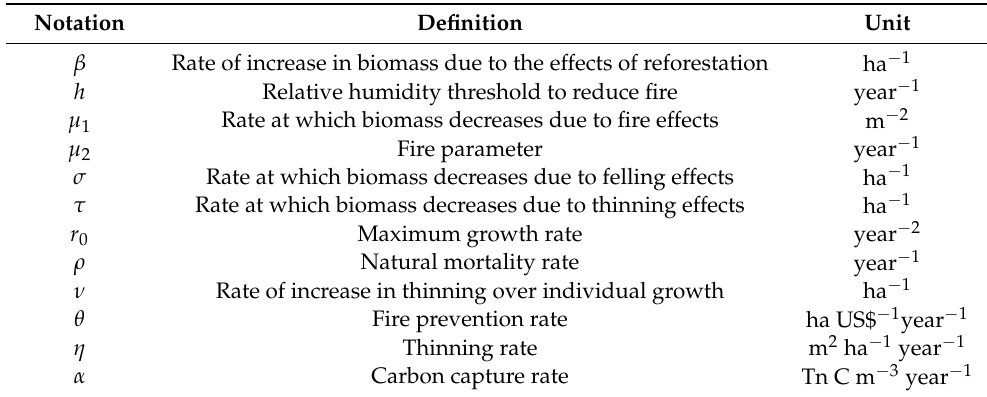
Table 2. Notation, definition, and units for each Table 1. Notation, definition, and units of each variable.